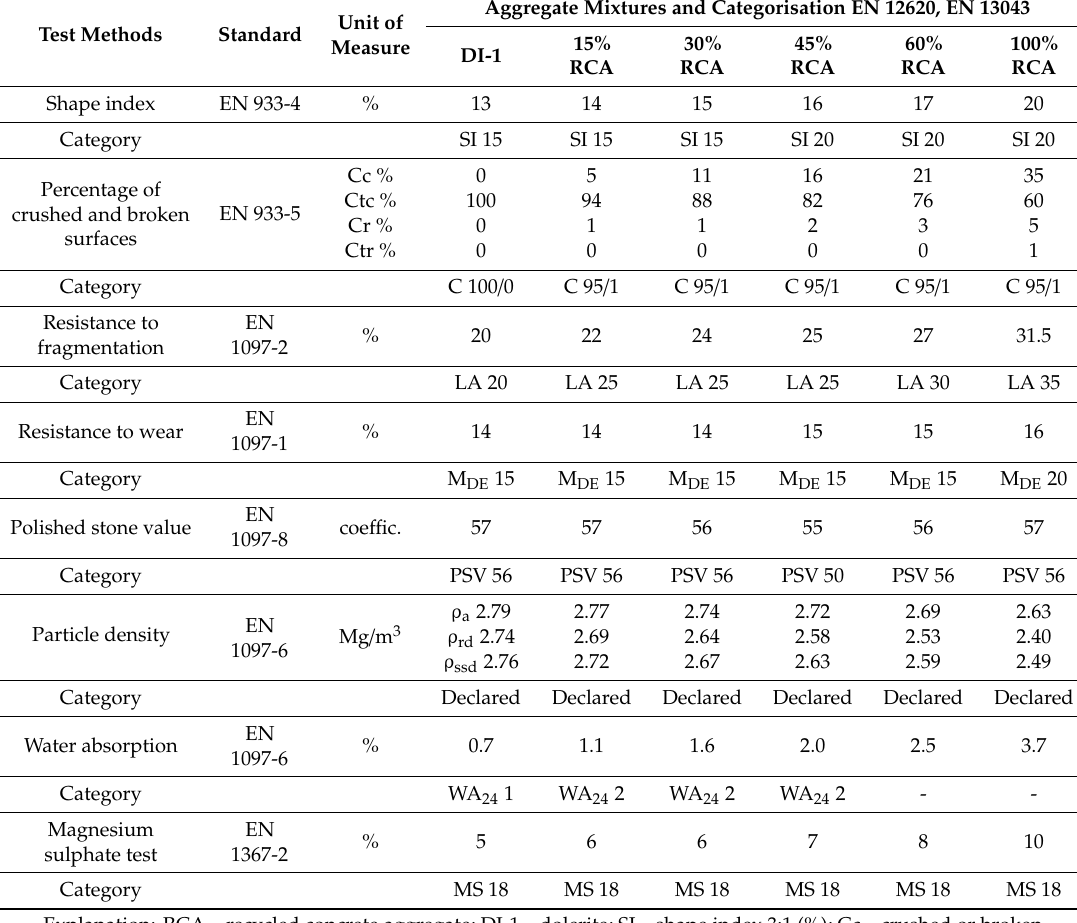
Table 4. Technical properties of aggregate mixtures and categorisation according to EN